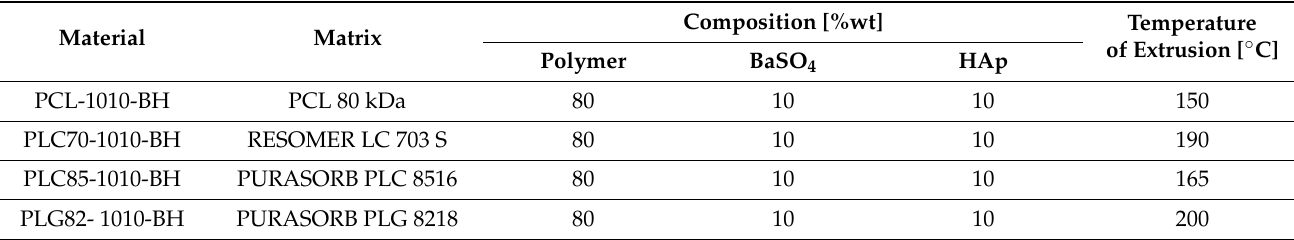
Table 2. Compositions of